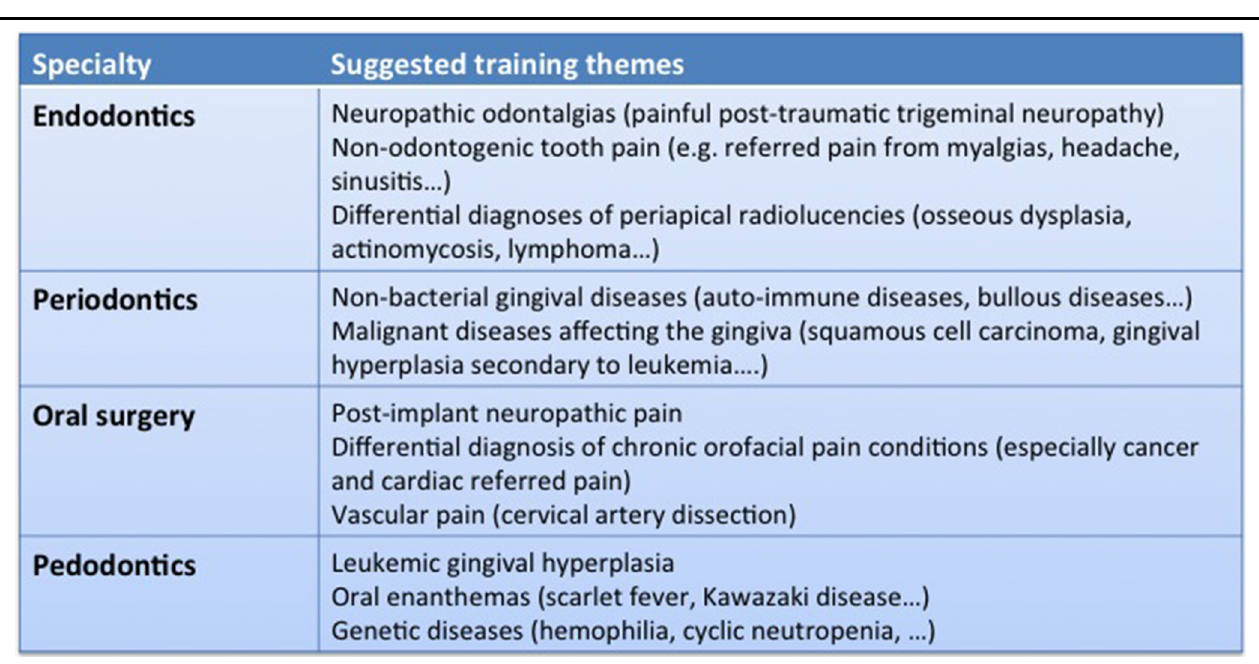
Table II. Suggested themes for Continuing Professional Development courses in several